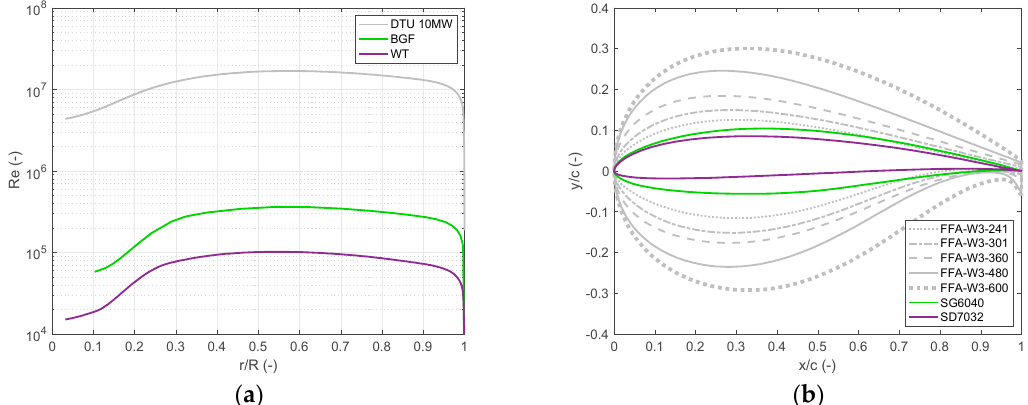
Figure 3. ( a ) Chord Reynolds number along the blade span at the rated operation for the outdoor prototype (BGF), wind tunnel model (WT) and DTU 10 MW. ( b ) Nondimensional shape of the airfoil for the outdoor prototype (SG6040), wind tunnel model (SD7032) and DTU 10 MW (FFA-W3-xxx).